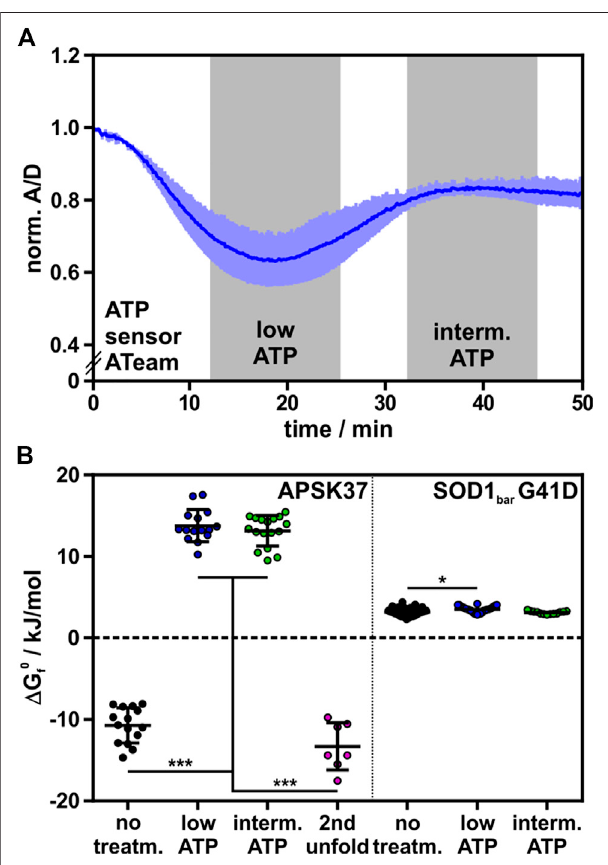
FIGURE 3 | Effect of ATP depletion on APSK37 in-cell stability. (A) NormalizedA/DsignalofATPsensorAteam1.03-nD/nAduringATPdepletion ofHeLacellswith1 mMKCNand10 mM2-deoxyglucose.Timeframesoflow ATP and intermediate ATP concentration are highlighted in grey. Measurements including folding-reporters were performed within these time frames. Bars re fl ect s.d. (n (cid:1) 3) (B) Standard free energy of folding at 37 ° C ( Δ G f0 ) of APSK37 and SOD1 bar G41D (non-binding control) during ATP- depleting conditions. Signi fi cant differences between data sets were tested usinganon-parametricKruskal-Wallistestfollowedbya post-hoc Dunn ’ stest for multiple comparisons (*** p < 0.001, * p < 0.05). Data points refer to single cells measured (exact numbers can be found source fi le of Figure 3B ). Bars refer to mean ±